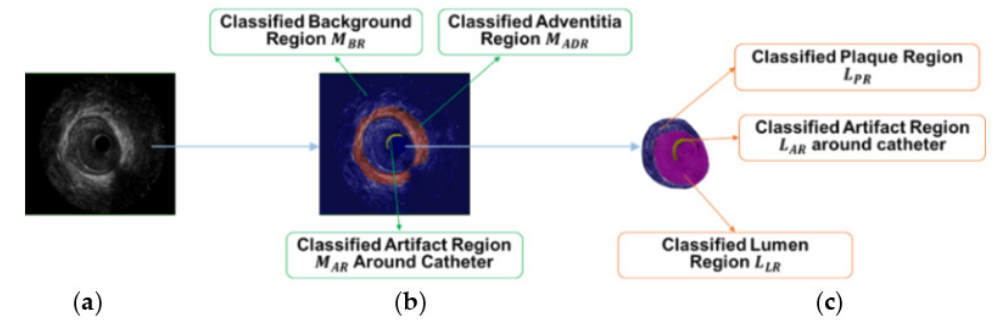
Figure 4. Support vector machine ( SVM) classification of image. ( a ) an IVUS image; ( b ) image regionalization results during MA border detection; ( c ) image regionalization results during lumen border detection.